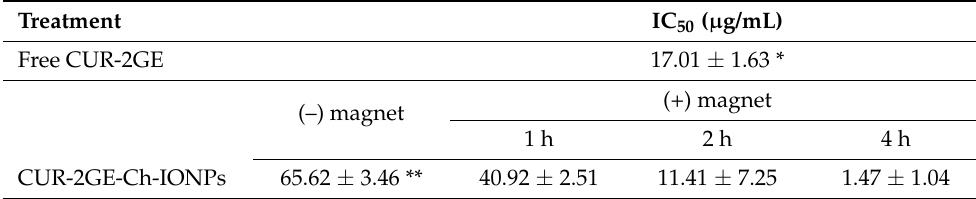
Table 4. Mean IC 50 values of the free CUR-2GE and CUR-2GE-Ch-IONPs against MDA-MB-231.